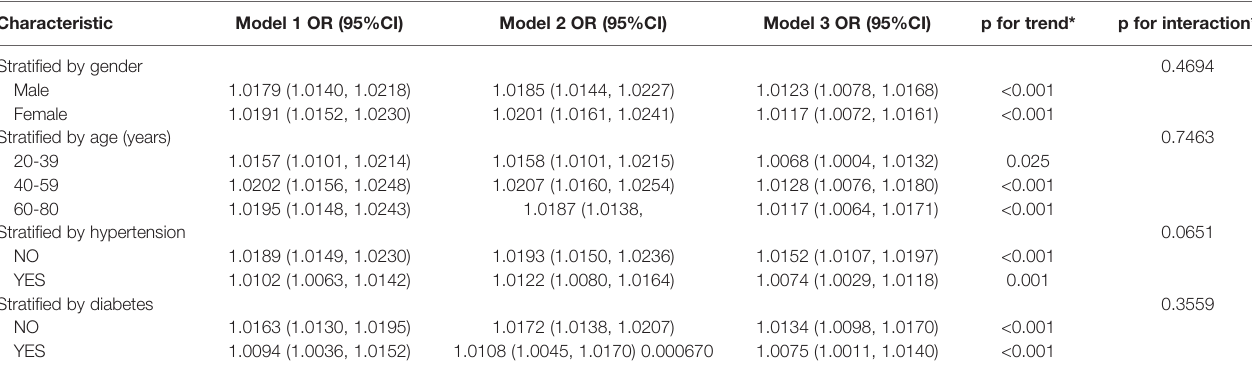
TABLE 4 | Subgroup analysis between METS-IR index with kidney stone formation.